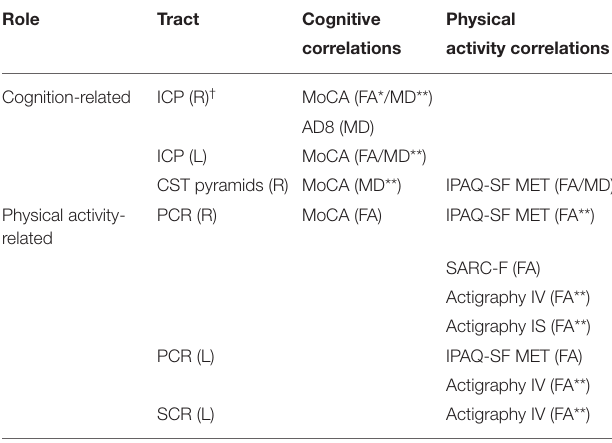
TABLE 4 | Summary of the tract-specific white matter integrity related to physical activity and cognition in